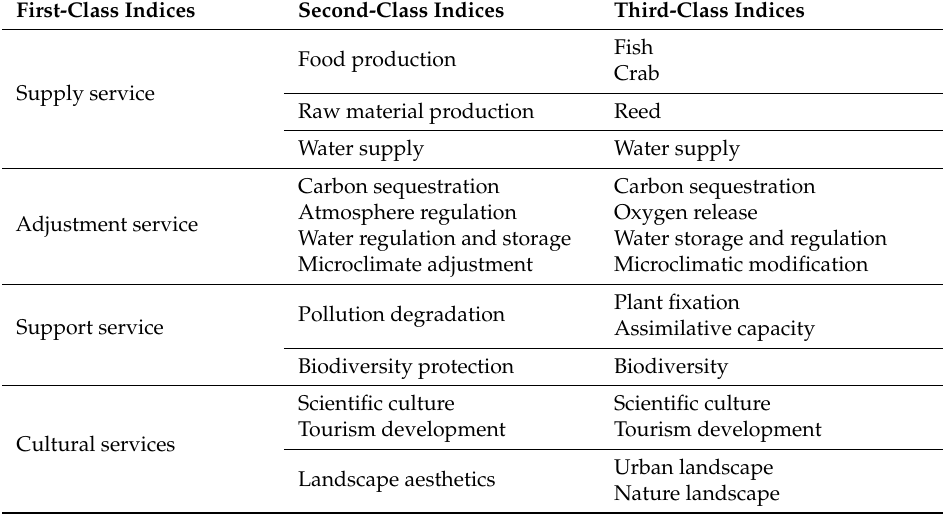
Table 1. Assessment index system for the incremental value of ecosystem